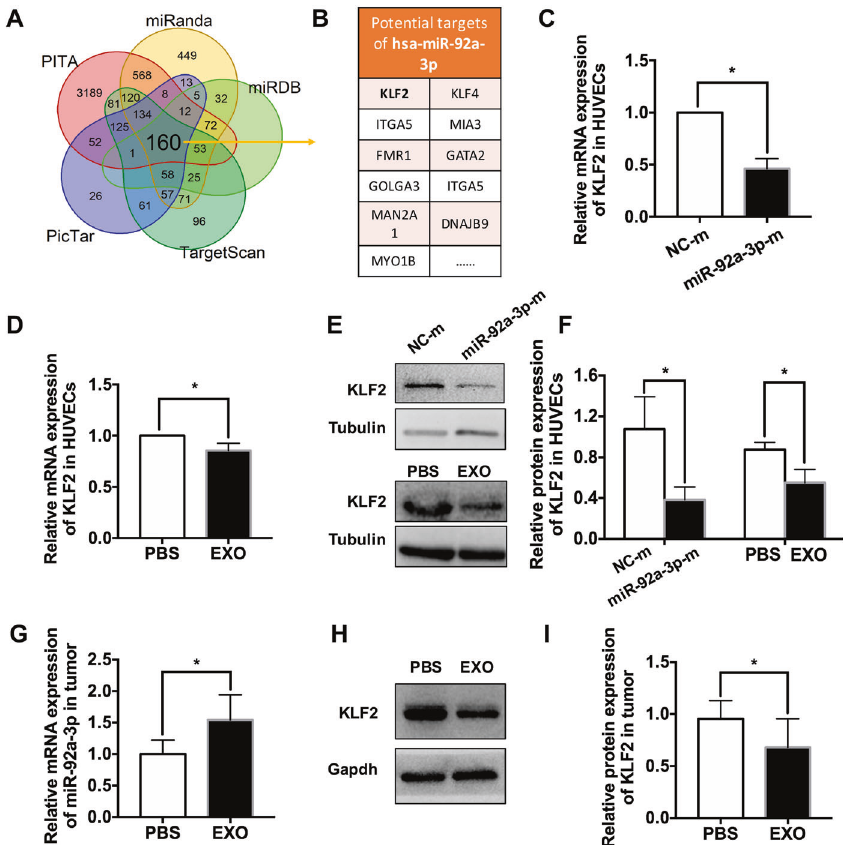
Fig. 7 Exosomal delivered miR-92a-3p modulates angiogenesis by targeting KLF2. A Venn diagram showing overlap of the data from miRanda, miRDB, TargetScan, PicTar, and PITA. B Potential targets of hsa-miR-92a-3p. C The mRNA level of KLF2 in the HUVECs transfected with synthetic mimic control (NC-m) or miR-92a-3p mimic (miR-92a-3p-m) ( n = 4, * P < 0.05). D The mRNA level of KLF2 in the HUVECs treated with PBS or EXOs ( n = 5, * P < 0.05). E Western blot analysis and relative quanti fi cation of protein expression indicating that exosome treatment or overexpression of miR-92a-3p could downregulate KLF2 expression in HUVECs ( n ≥ 6, * P < 0.05). G The mRNA level of miR-92a-3p in the tumor tissues treated with PBS or exosomes ( n = 6, * P < 0.05). H Representative blots of KLF2 in the tumor tissues treated with PBS or exosomes. I Quantitative evaluation of KLF2 protein expression in the tumor tissues treated with PBS or exosomes ( n = 6, * P <